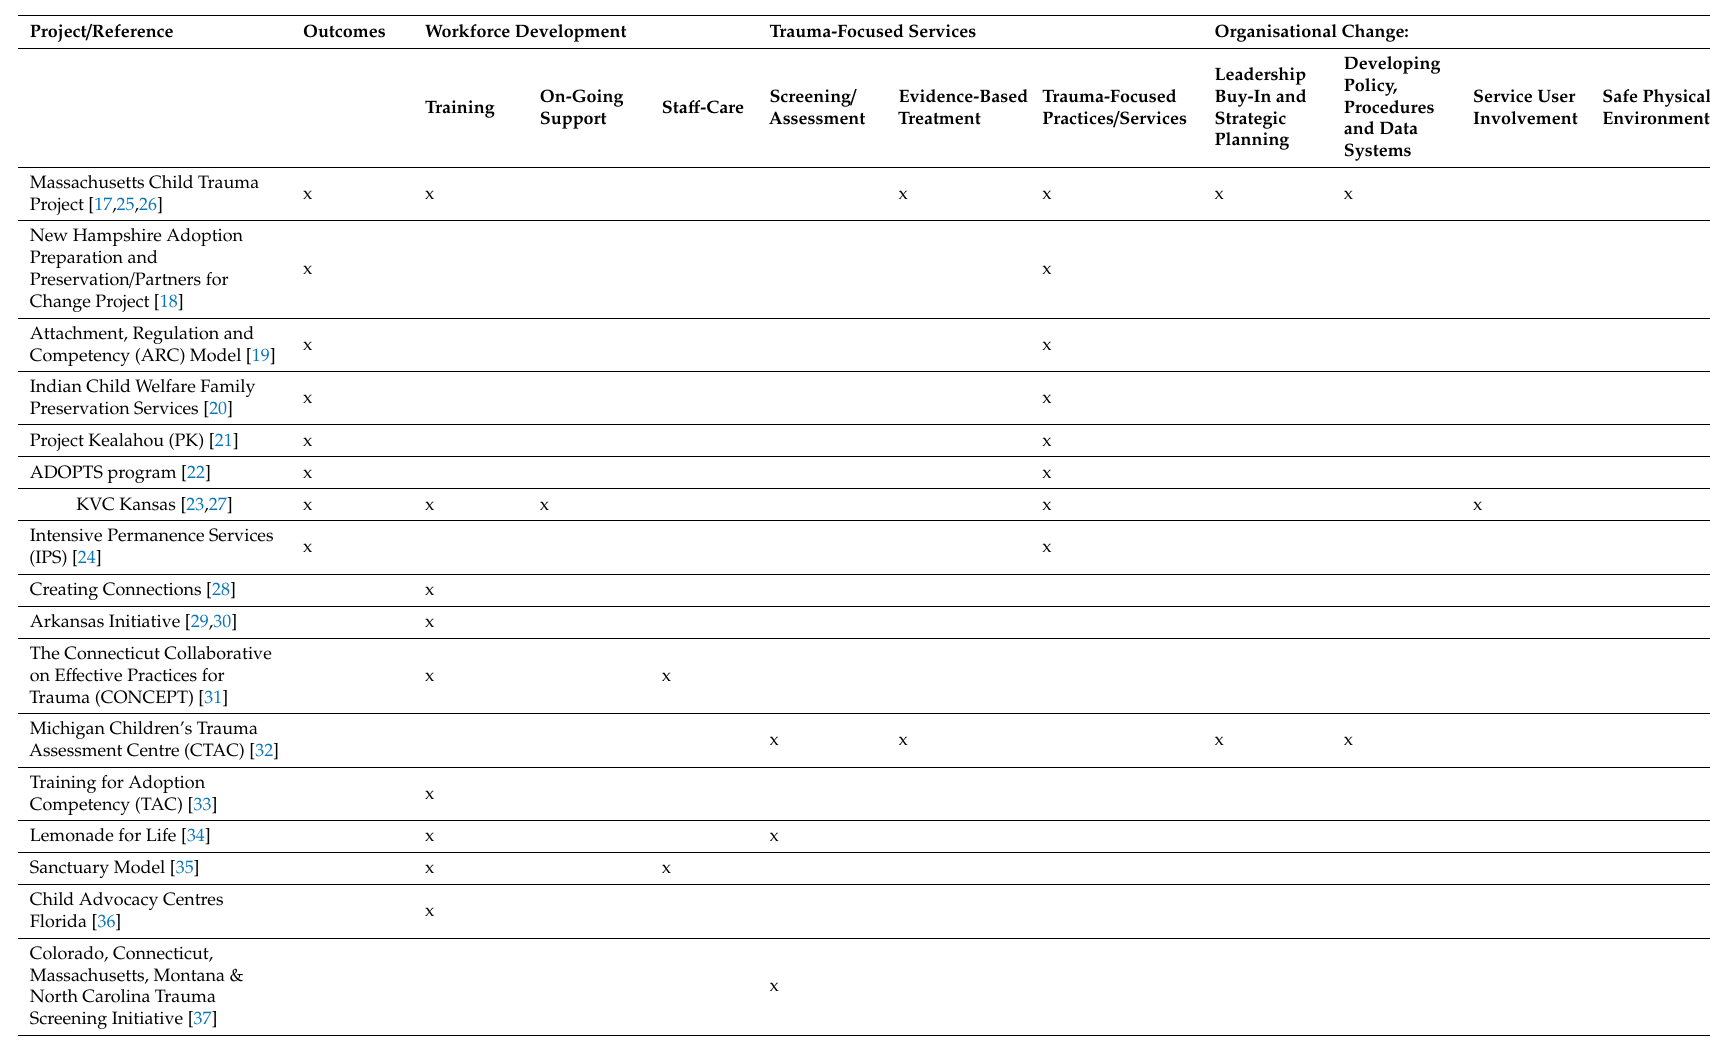
Table 2. Implementation domains with evaluation